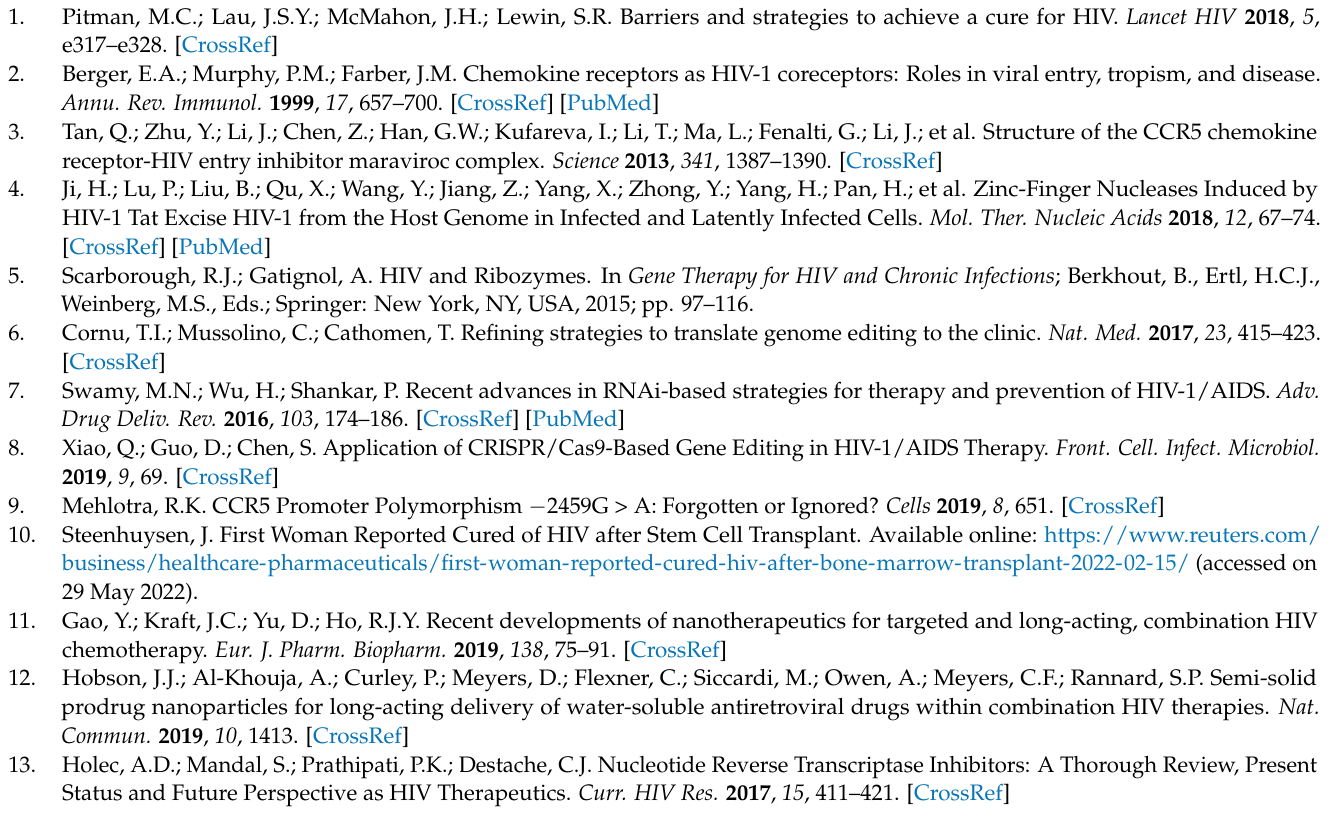
xfR5 mAb interaction with CCR5 receptors on T cell binding; Figure S2: Schematic diagram explaining immunophenotype study design; Figure S3: Flow cytometry gating strategy to evaluate T cell binding affinity; Figure S4: Flow cytometry gating strategy to evaluate T cell differentiation pattern upon xfR5-D+T NPs and xfR5 mAbs (free) treatment (at 66.5 nM of xfR5 mAb concentration as NP bound or free); Figure S5: A graphical presentation of comparative binding of Cy3 tagged xfR5-D+T NPs vs. different variables; Figure S6: T-cell differentiation phenotype after D+T NP vs. xfR5 NPs treatment under (A) protection against HIV challenge (HIV prophylaxis), and (B), HIV infected T-cell treatment (HIV treatment) condition; Table S1: Comparative one-way ANOVA analysis (using Tukey’s multiple comparison test) of CC 50 of TZM-bl and PBMCs; Table S2: Comparative one-way ANOVA